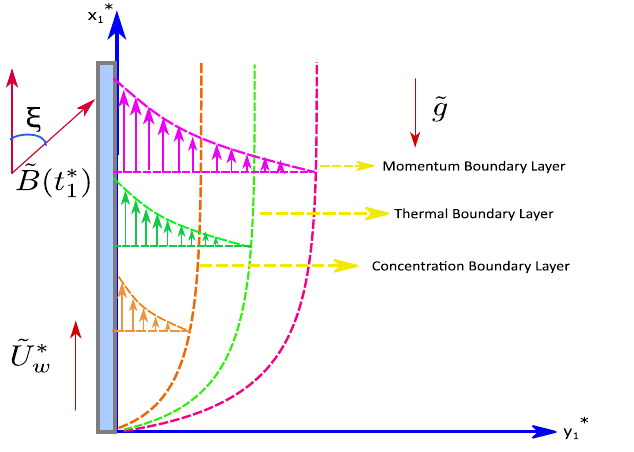
Figure 1. A pictorial representation of the